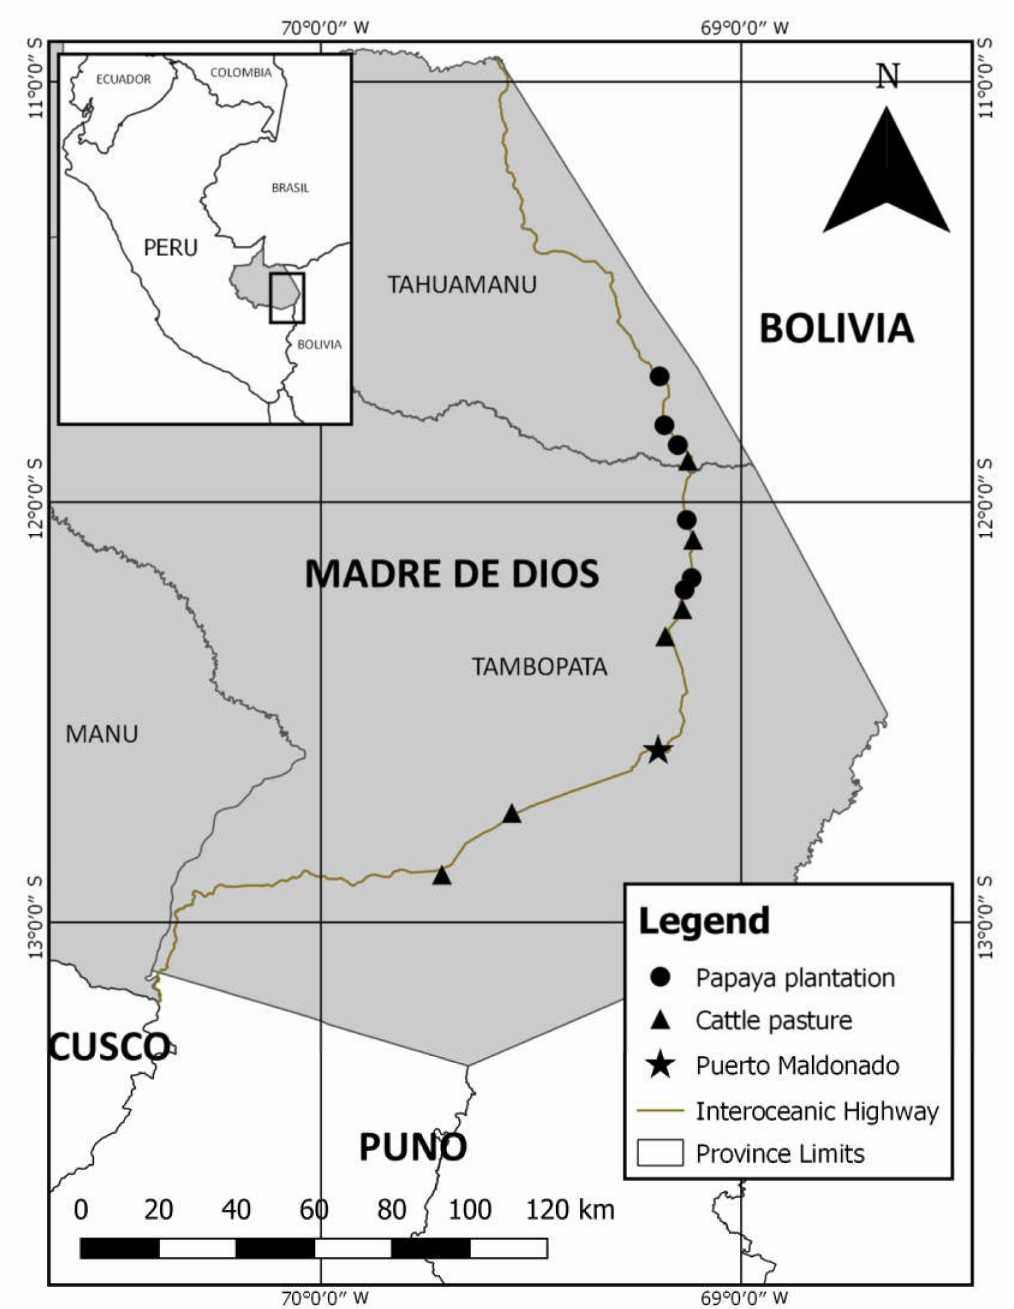
Figure 1. Location of the 12 sampling sites in Madre de Dios,